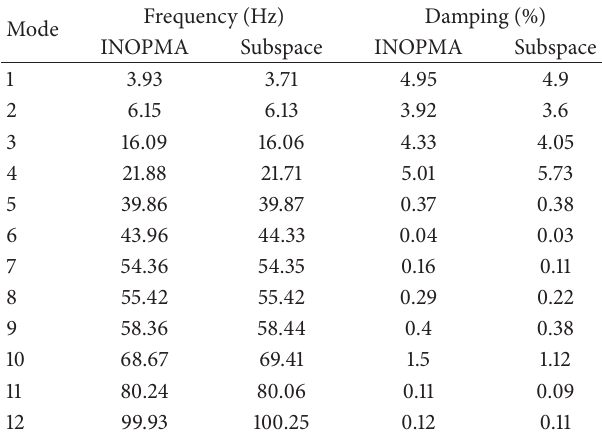
Table 1: Identification results: INOPMA versus